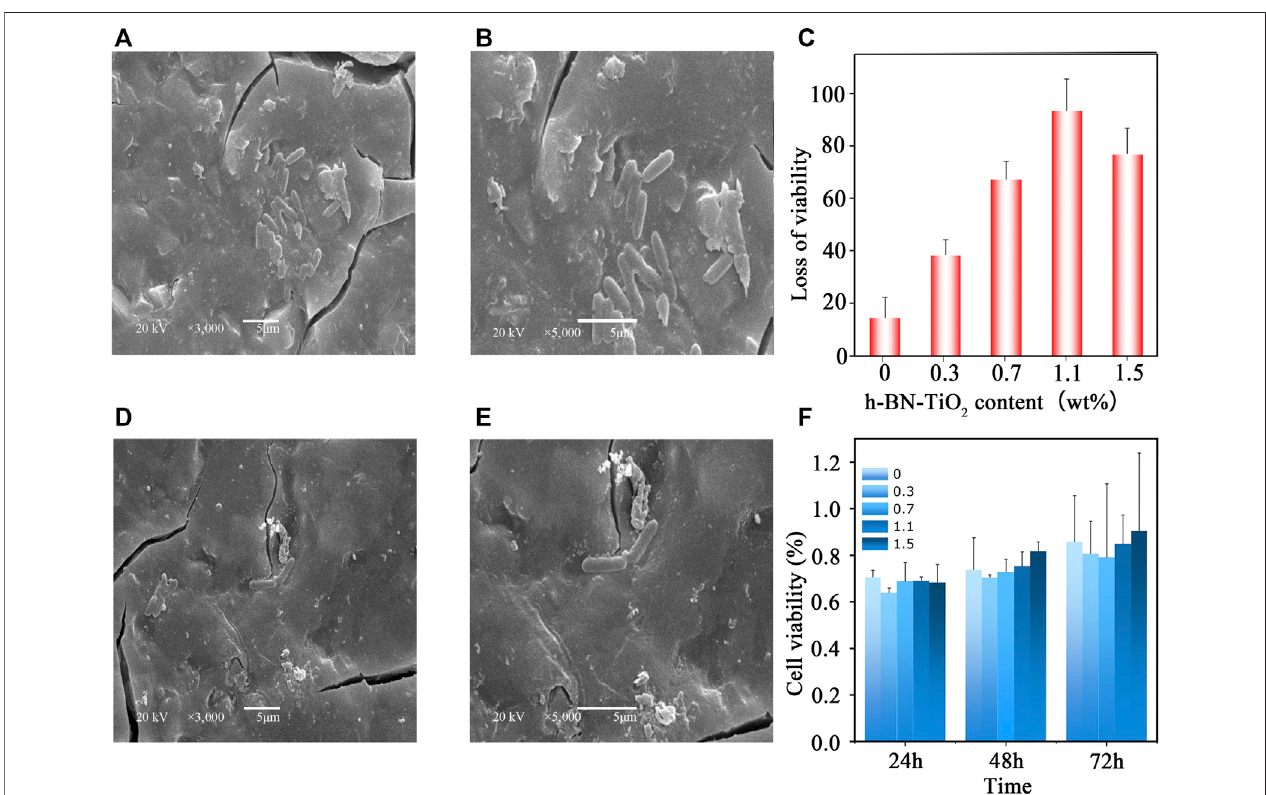
FIGURE 7 | The SEM micrograph of the colony of representative samples from the groups of h-BN-TiO 2 /GIC: 0 wt% h-BN-TiO 2 /GIC (A) magni fi cation ×3,000; 0 wt.%h-BN-TiO 2 /GIC (B) ,magni fi cation ×5,000;1.1 wt.%h-BN-TiO 2 /GIC (D) ,magni fi cation×3,000;1.1 wt.%h-BN-TiO 2 /GIC (E) ,magni fi cation×5,000;Thein fl uence of different concentrations of the h-BN-TiO 2 /GIC composites on the loss of viability in S. mutans (C) and the cell viability of the L-929 cells cultured in h-BN-TiO 2 /GIC extract (F)